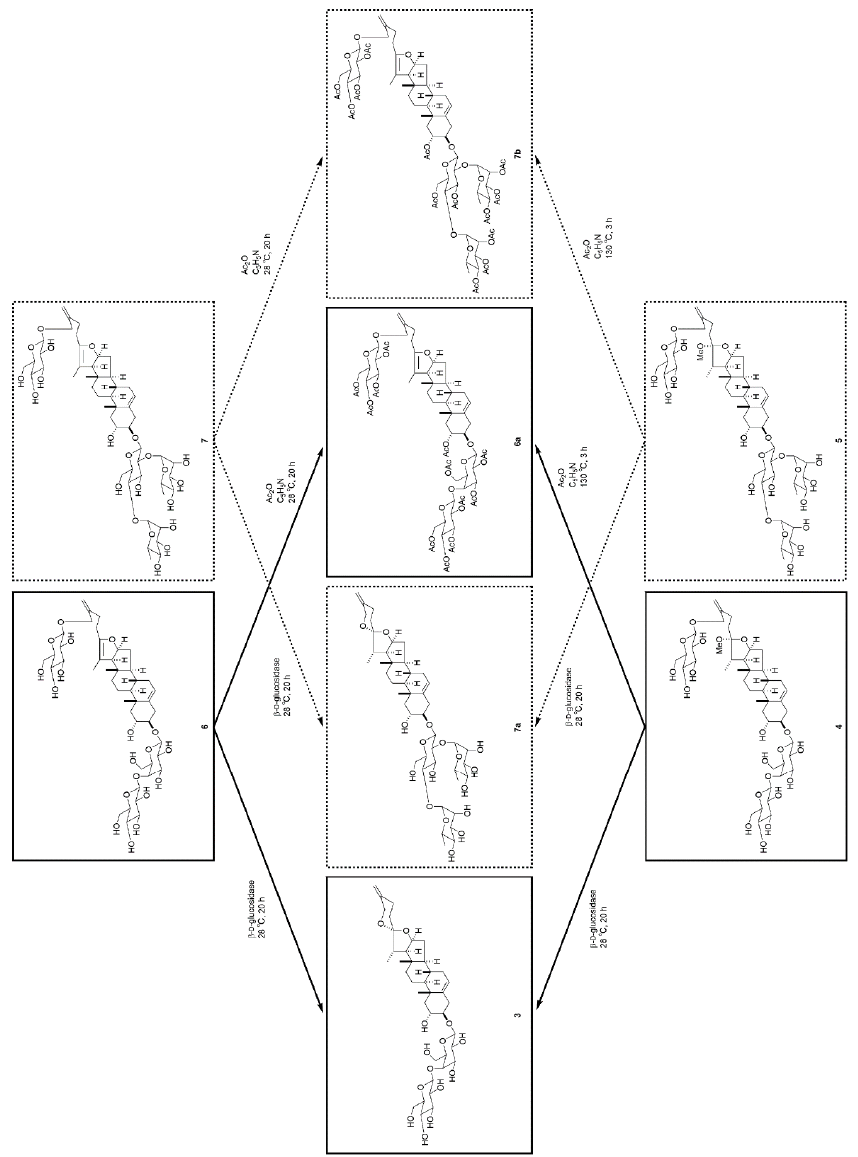
Figure 4. Chemical transformations of 4 – 7 .